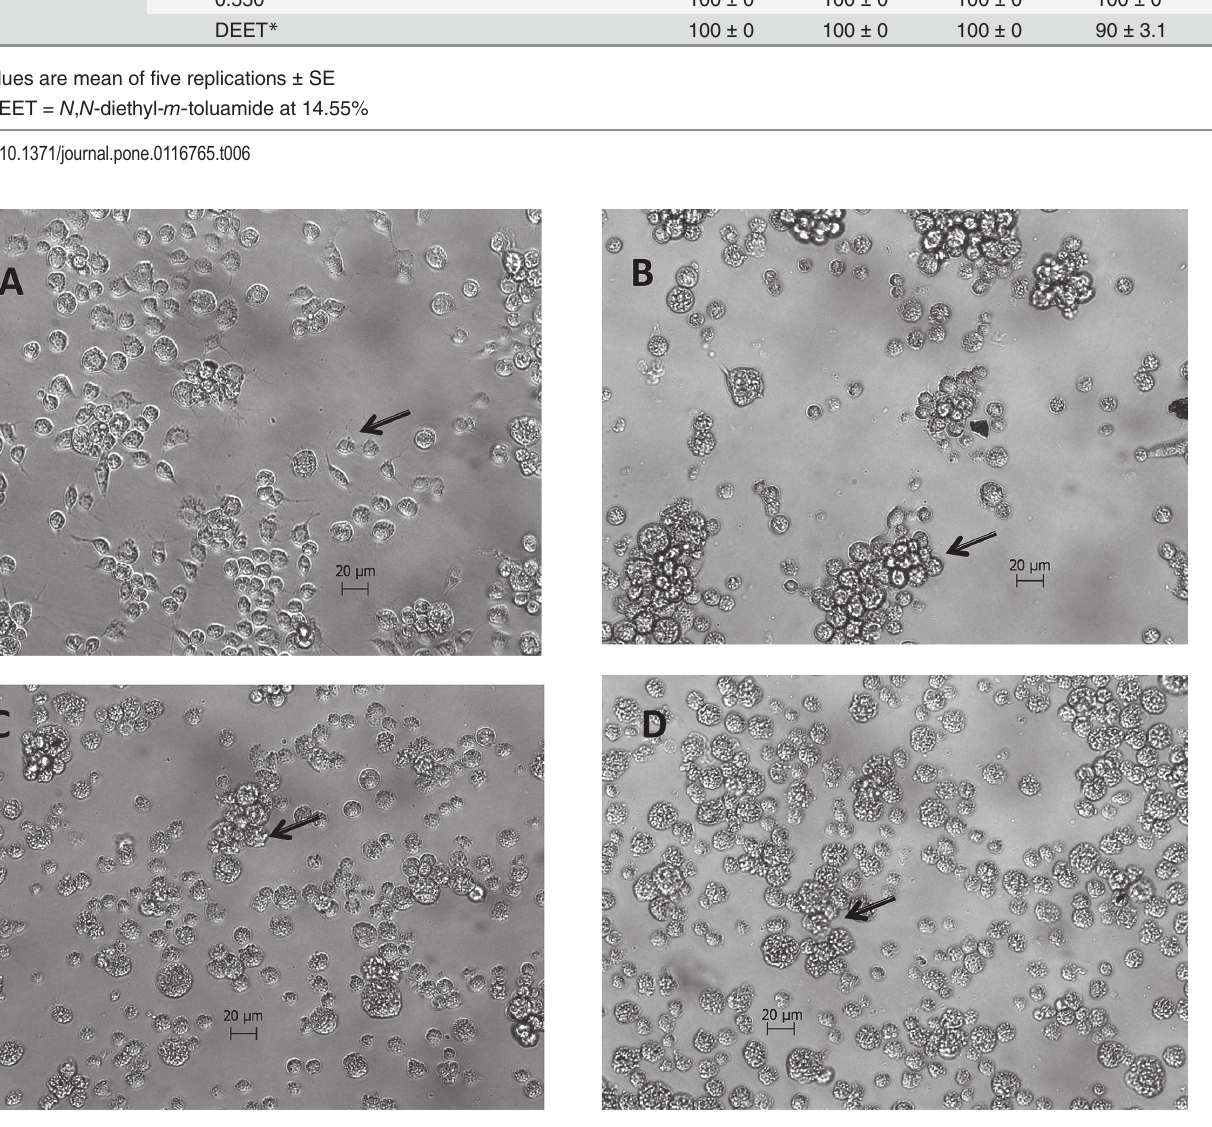
Figure 3. Light micrographs of C6/36 cells of A . albopictus treated with essential oil of S . guianensis after 2 h. A: C6/36 cells treated with DMSO + medium. B, C, and D: C6/36 cells treated with essential oil of S . guianensis at concentrations 0.2, 0.4, and 0.8 µ g/mL,